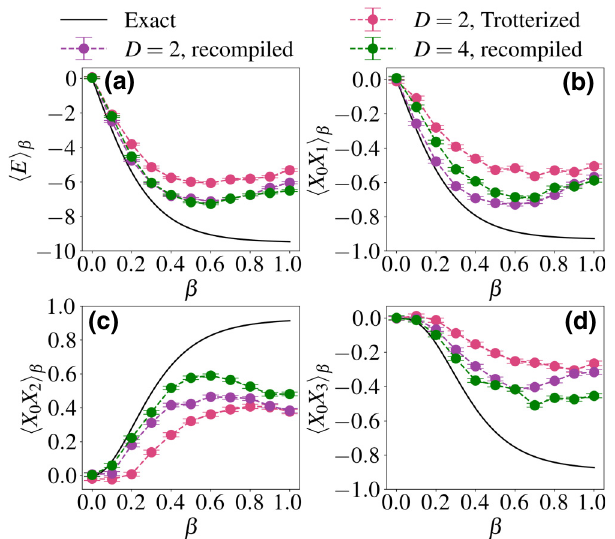
FIG. 8. (a) Finite-temperature energy (cid:9) E (cid:7) β and static corre- lation functions (b) (cid:9) X 0 X 1 (cid:7) β (c) (cid:9) X 0 X 2 (cid:7) β (d) (cid:9) X 0 X 3 (cid:7) β of the four-site TFIM with J = 3, h = 1 versus inverse temperature β with different QITE unitaries. The imaginary-time-step size in QITE is set to (cid:3)τ = 0.05. The D = 2 QITE unitaries are either Trotterized as in Eq. (4) or recompiled, while all D = 4 QITE unitaries are recompiled. The results with recompiled QITE uni- taries are closer to exact results than the results with Trotterized QITE unitaries due to circuit depth. Between the calculations with recompiled unitaries, D = 4 is not necessarily closer to exact results than D = 2 for all observables, possibly due to the increased influence of hardware noise in the larger linear systems.